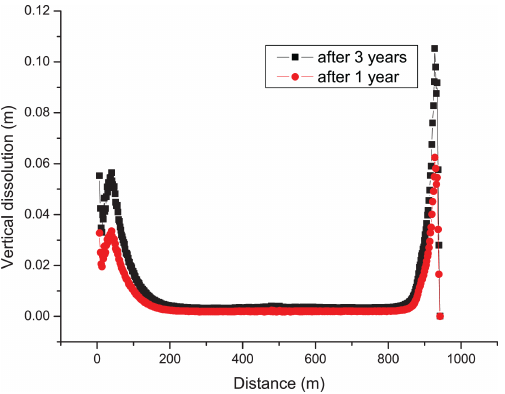
Figure 10. Dissolved salt over each element after 3years of simu- lation with 6 each of 15m wide faults.